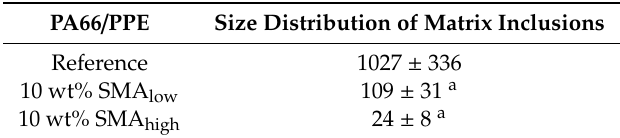
Figure 6. TEM micrographs of PA66 / PPE blends with 10 wt% SMA high ( left ) and SMA low ( right ). Herein, sub-micron sized black spots are distributed all over the matrix having a diameter of 100 nm and smaller in size for both SMA. The size distribution of the small inclusions together with the PPE domain size distribution of the reference without SMA is given in Table 3. Table 3. Domain size distribution analysis of SMA compatibilized PA66 / PPE ternary blends based on the TEM micrographs from Figure